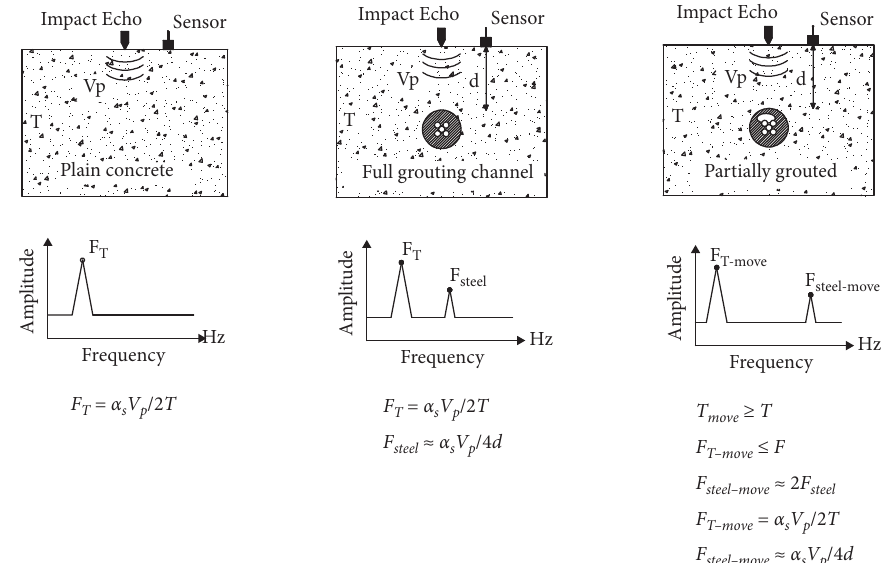
Figure 2: Response spectrum analysis diagram of different channels. Table 1: Material parameters.